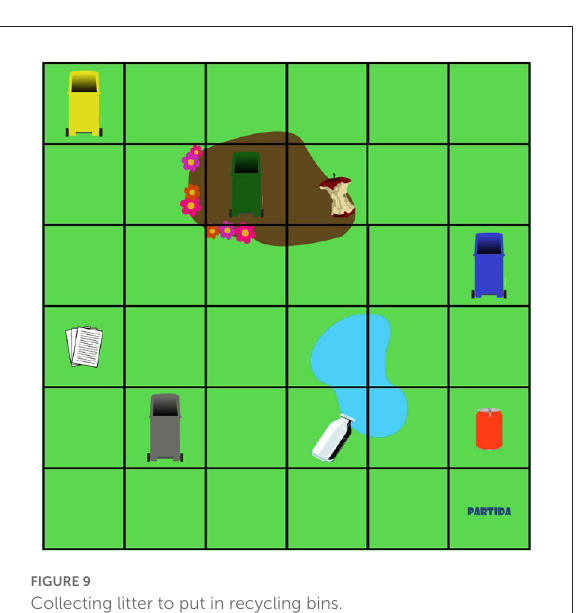
FIGURE9 Collecting litter to put in recycling